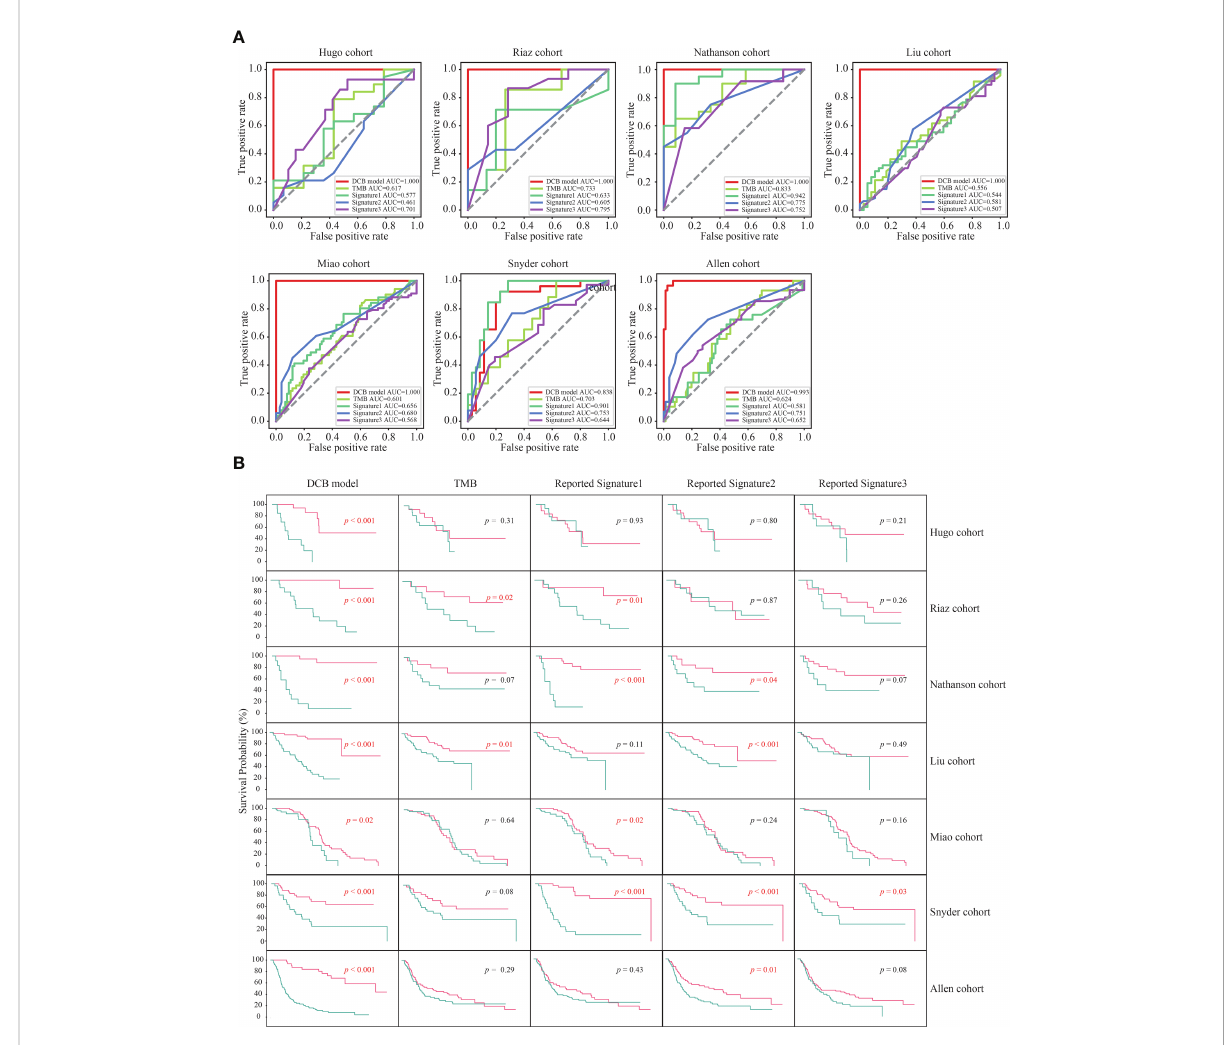
FIGURE 4 The predictive ability of the DCB model was superior to TMB and other reported genetic mutation signatures. (A) ROC curves of the DCB model, TMB and reported genetic mutation signature 1, 2 and 3 in the seven melanoma cohorts. (B) Kaplan – Meier curves of OS comparing pDCB with pNDB from the DCB model, TMB and reported genetic mutation signature 1, 2 and 3 in the seven melanoma